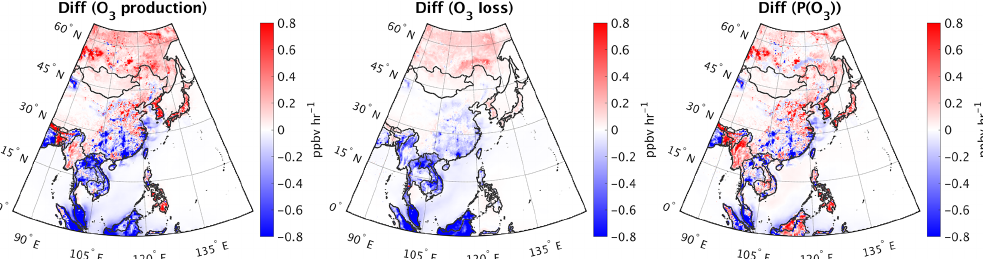
Figure 10. Changes in the major chemical pathways of ozone production and loss over the surface, as well as the net ozone production P ( O 3 ) after updating the emissions. The time period is May–June 2016,